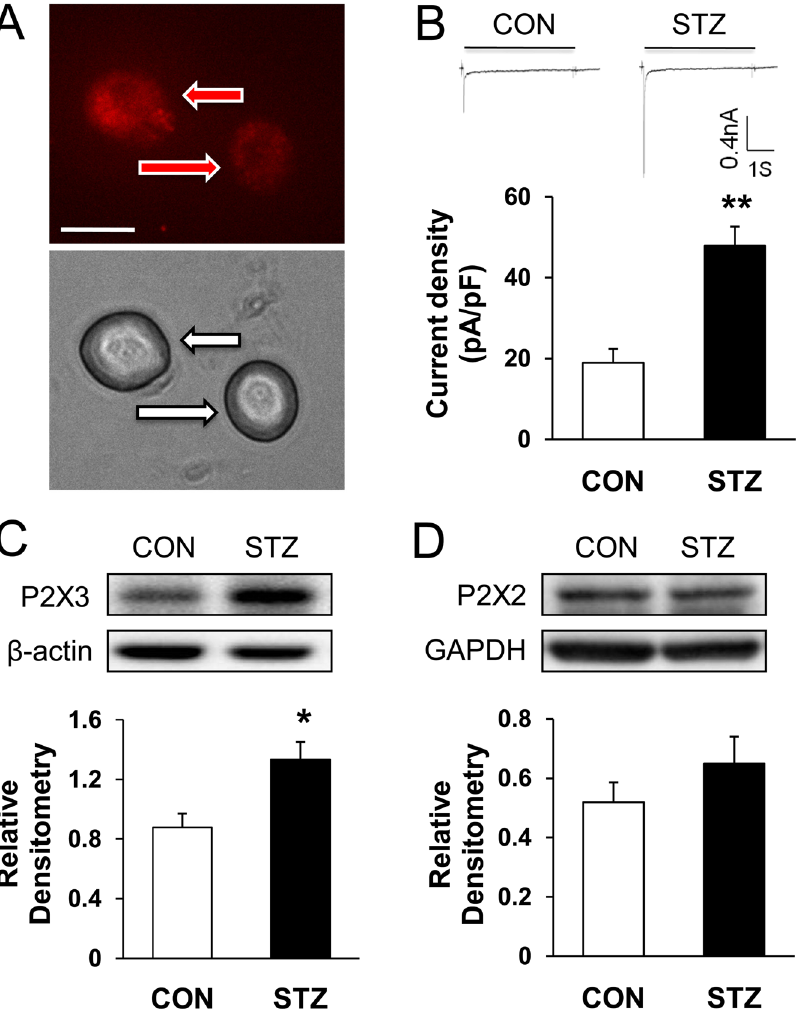
Figure 2. Enhanced ATP current density and upregulated expression of P2X3 Rs in diabetic rats 4 weeks after STZ injection. ( A ) Top: An example of two Dil-labeled DRG neurons (red arrow) innervating colon. Bottom: Phase image of the same DRG neurons labeled by DiI is shown (white arrow). Scale bar = 50 μ m. Patch-clamp recordings were performed on DiI-labeled colon-specific neurons. ( B ) Top: An example of ATP evoked inward currents in DiI labeled neurons under voltage clamp conditions. Bottom: Bar graph showing an average of ATP- induced current density of DiI labeled DRG neurons from control and diabetic rats. The average peak current density obtained from control and diabetic rats were 19.0 ± 3.4 pA/pF and 47.9 ± 4.7 pA/pF, respectively (n = 9 cells for each group, ** p < 0.01 compared with CON, two sample t -test). ( C,D ) Western blots for P2X3R (C) and P2X2 R ( D ) of T13-L2 DRGs from CON and STZ-injection rats. Bar graph showed mean density relative to β -actin for P2X3 R and to GAPDH for P2X2 R from CON and STZ rats. STZ injection greatly enhanced expression of P2X3Rs (n = 5 rats for CON, n = 7 rats for STZ, respectively, * p < 0.05, compared with CON, two sample t -test), but not significantly altered expression of P2X2 R (n = 5 for each group, p > 0.05, compared with CON, two-sample t